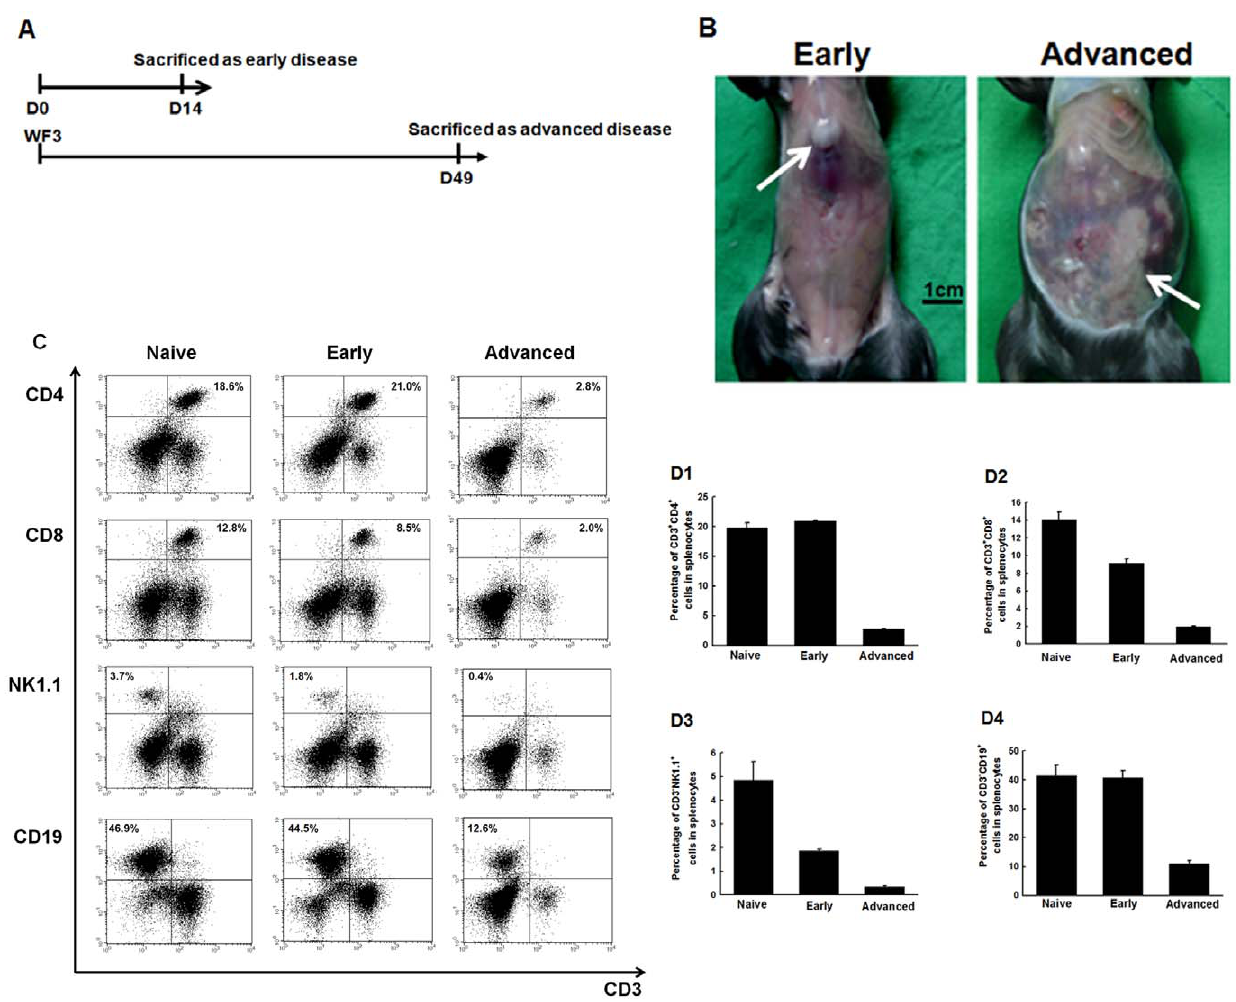
Figure 2. Alterations of systemic immune effector cells in splenocytes of mice challenged with PBS or WF-3 tumor cells. ( A ) Diagrammatic representation of the collection of specimens in early and advanced diseases. ( B ) Representative figures of mice after WF-3 challenge at days 14 and 49. Note : Only small tumors (arrow) with little ascites were identified in mice of early disease. However, disseminated tumor implants (arrows) with bloody ascites within the whole peritoneal cavity were noted in mice with advanced disease. ( C ) Representative figures of flow cytometric analyses of various kinds of lymphocytes in splenocytes. ( D ) Percentages of various kinds of lymphocytes in splenocytes of naı¨ve mice and in mice of early and advanced diseases. D1, CD4 + helper T lymphocytes; D2, CD8 + cytotoxic T lymphocytes; D3, NK1.1 + natural killer cells; and D4, CD19 + B lymphocytes. Note : All of the percentages of systemic immune effector cells significantly decreased as the tumor progressed from early to advanced stage.